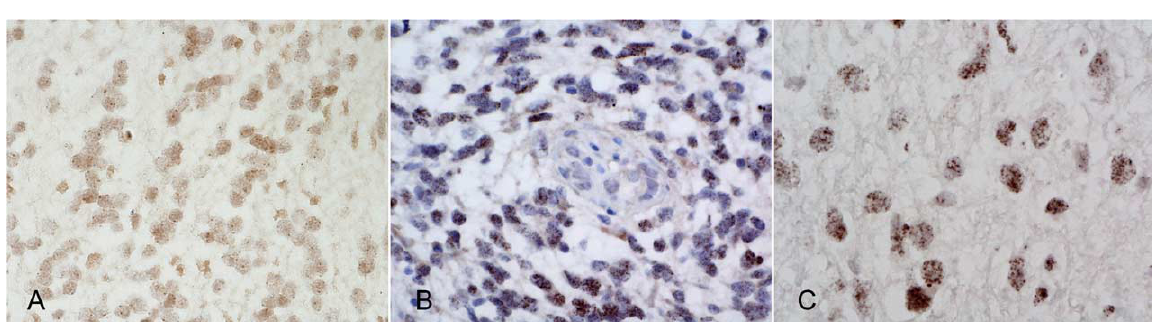
Fig. 2. CISH analysis of KIT amplification status in CD117 expressing gliomas. (A) Oligodendroglioma without KIT amplification (600 × , no H.E. counterstaining). (B) Glioblastoma with KIT amplification (600 × , H.E. counterstaining). (C) Anaplastic oligoastrocytoma with KIT amplification (1000 × , no H.E.